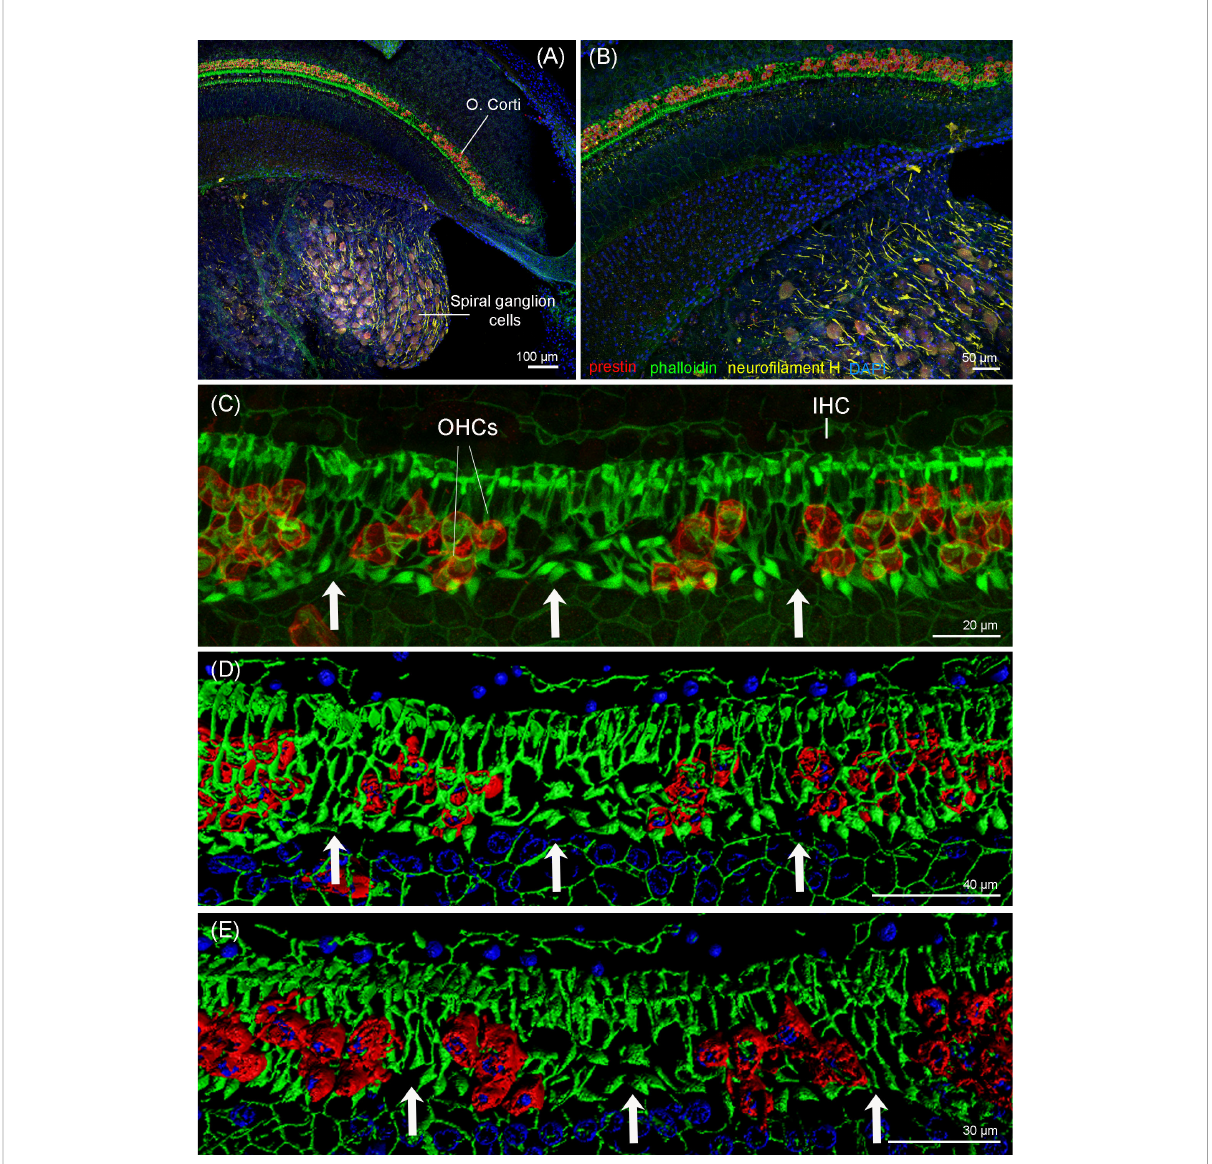
FIGURE 8 Maximum projections (up to 289 planes each 0.3 – 3 m m, depending on the magni fi cation) from confocal microscope images of the beginning of the apex of the right cochlea of the harbor porpoise at 10× (A) , 20× (B) , and 63× (C) magni fi cation. The white arrows highlight the regions with evidence of outer hair cell loss. (D, E) 3D reconstruction of the region of the cochlea in (C) from the vestibular (D) and tympanic (E) scala. The apical turn of the cochlea was labeled with anti-prestin (red) and anti-neuro fi lament H (yellow) antibodies; phalloidin (green) and nuclei were counterstained with DAPI